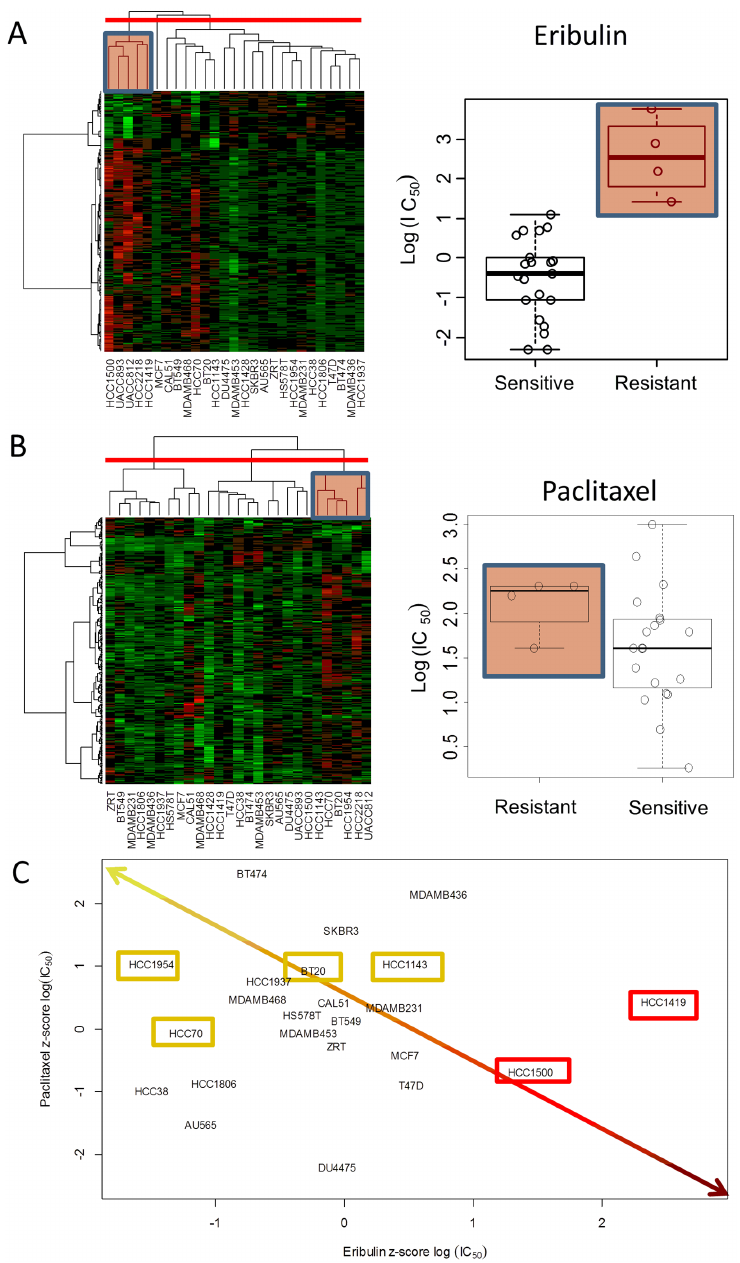
Figure 2. Correlation of expression profiles with drug sensitivity. A) Correlation of eribulin signature with drug sensitivity. Hierarchical clustering of eribulin expression signature identified two clusters of cell lines with significantly different sensitivity to eribulin (p=0.004). The red box indicates the eribulin resistant cluster. B) Correlation of paclitaxel signature with drug sensitivity. Hierarchical clustering of paclitaxel expression signature identified cluster with differences of paclitaxel sensitivity (p=0.06). The red box indicates the most paclitaxel resistant cell line cluster. C) Scatter plot of eribulin and paclitaxel sensitivity. Cell lines located in the upper left corner are the most resistant to paclitaxel as compared to eribulin, and cell lines located at the lower right corner are the most resistant to eribulin as compared to paclitaxel. Yellow and red boxes indicate the cell lines identified based on expression profiles as uniquely resistant to paclitaxel and eribulin, respectively. doi:10.1371/journal.pone.0106131.g002 The correlative analysis of the signature gene sets with altered for enrichment analysis and a significance threshold of p , 0.05 was expression between treatments indicated a significant correlation applied with the FDR adjustment. Table 3 shows the significantly with drug sensitivity for breast and endometrial but not for ovarian enriched pathways grouped as common and unique for the different cancer panels. There were several common pathways for cancer (Table 1). We investigated the functional role of the genes differentiating eribulin from paclitaxel based on gene expression the 3 cancer types: cytoskeleton remodeling related pathways by performing pathway enrichment analysis using the commer- (neurofilaments and keratin filaments), and the role of Nek in the cially available Metacore software. The three genes sets were used cell cycle regulation pathway. Breast and endometrial cancers